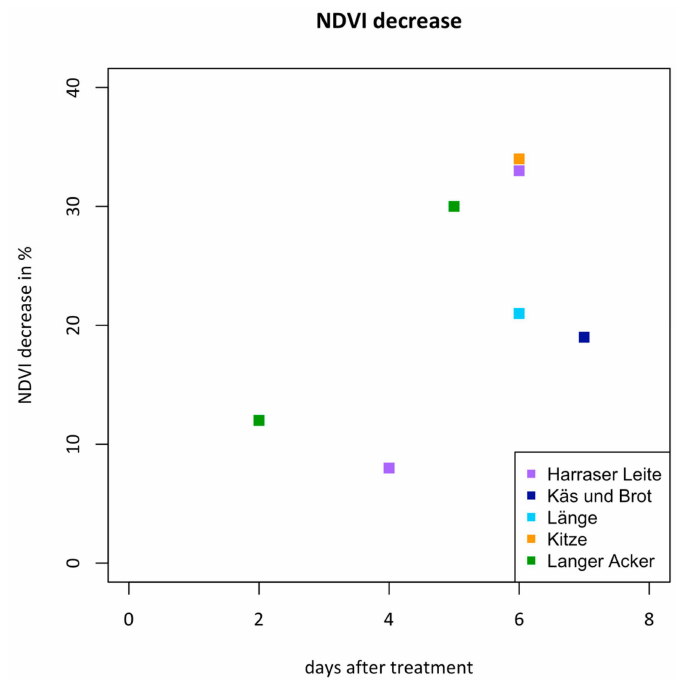
Figure 5. Decreasing NDVI values in percent (%) for all test sites up to seven days after GBH